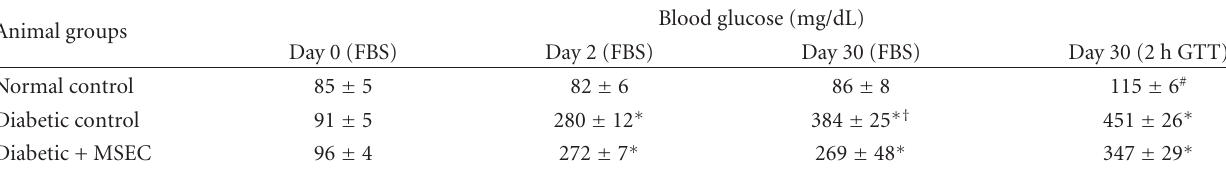
Table 2: E ff ect of long-term administration of MSEC on blood glucose level in diabetic rats. Animal groups